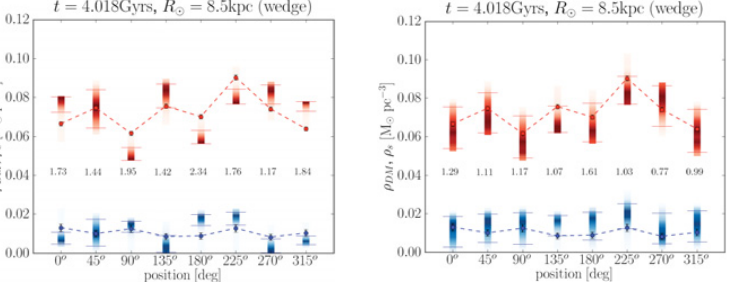
Figure 1. Density of models explored by the MCMC (for 8 volumes around the disc) represented as shaded areas of different colours (blue = (cid:1) dm , red = (cid:1) s ). The filled dots represent the corresponding actual values from the simulation (with Poisson error bars), the horizontal segments are the 90% confindence ranges. Left panel: standard method, Right Panel: MA